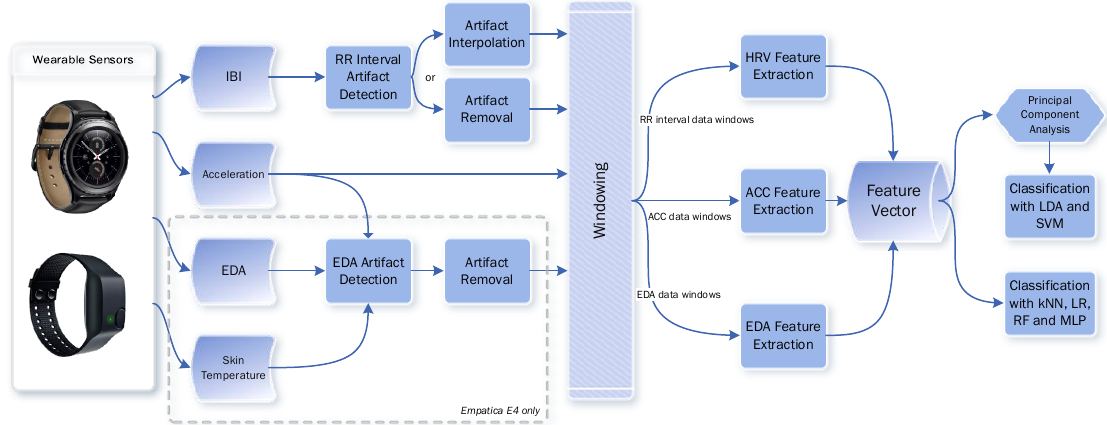
Figure 2. The block diagram of the stress level detection system for Samsung Gear S and S2 and Empatica E4. Since the sensors and platforms are different, please note that EDA and temperature signals are only available for